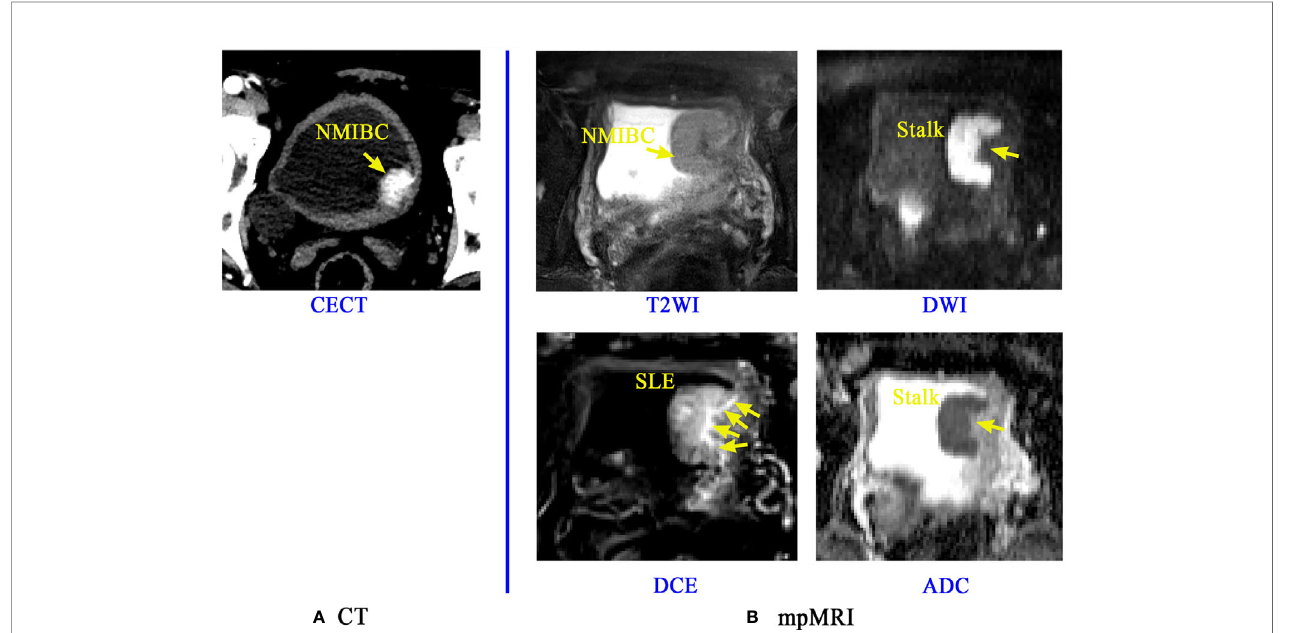
FIGURE 1 | Application of CT and mpMRI for the preoperative prediction of the muscle invasion status of BCa. A lesion of a patient con fi rmed with NMIBC is discernible on Contrast-enhanced CT (CECT) image (A) , but the boundaries and basal part of this lesion is rarely distinguishable. The mpMRI (B) including the T2WI, DCE, DWI and its corresponding ADC map can provide more important signs and information like the stalk at the tumor base and submucosal linear enhancement (SLE) for accurate diagnosis of muscle-invasive status (MIS) of BCa